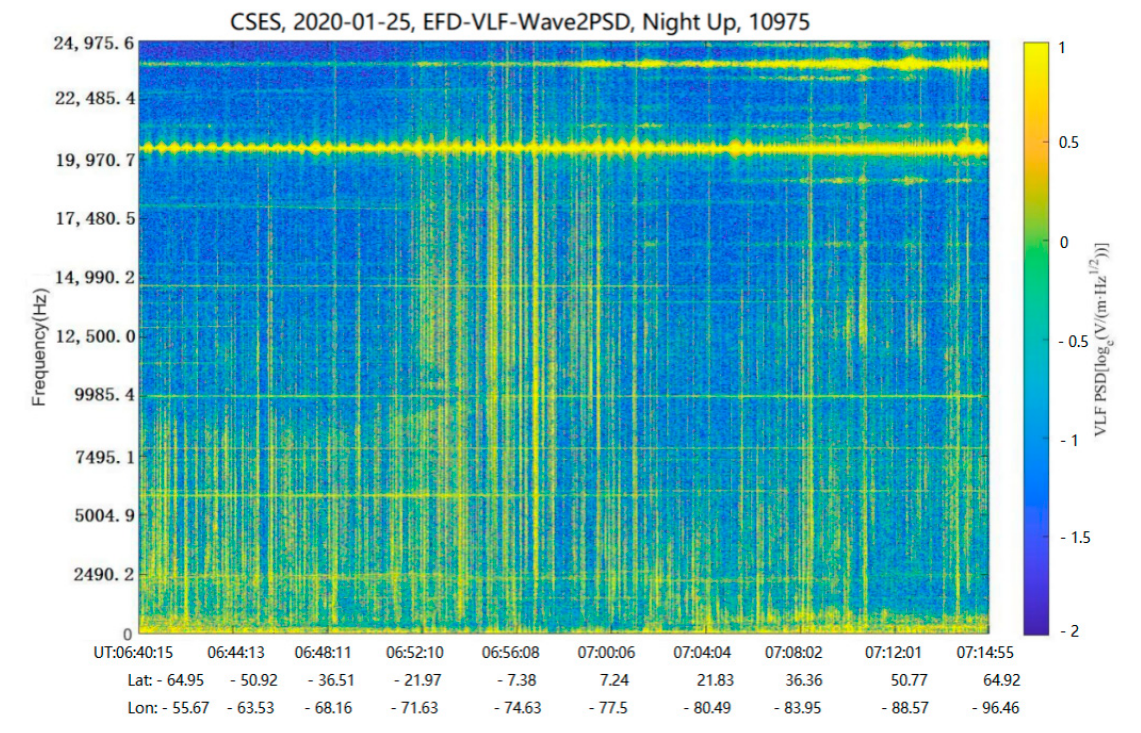
Figure 1. VLF from 6:40 a.m. to 7:14 a.m. on 25 January 2020 CSES waveform spectrogram.